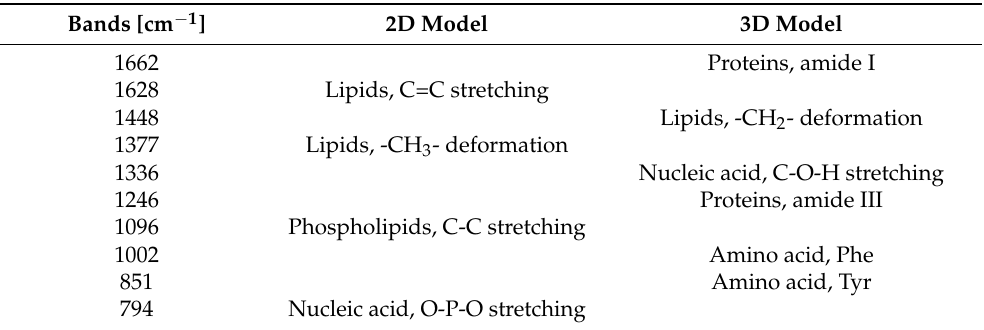
Figure 3. ( a ) Projection of Raman spectra onto a 2D PCA score space for the 2D and 3D models; 95% confidence ellipses enclosing the projected spectra as dots on the PCA score space are also shown. ( b ) Loading plot of the PC1 and PC2 for the spectra of 2D and 3D models; the black line represents the loading of PC1, and the red line represents the loading of PC2, the grey and red bands indicate the characteristic Raman shifts for the 2D and 3D models, respectively. ( c ) Results of the classification prediction for the PCA of the 2D and 3D models using the KNN algorithm. Table 2. Raman shifts and tentative assignments of characteristic Raman bands found from PCA for 2D and 3D models [19,20,25].